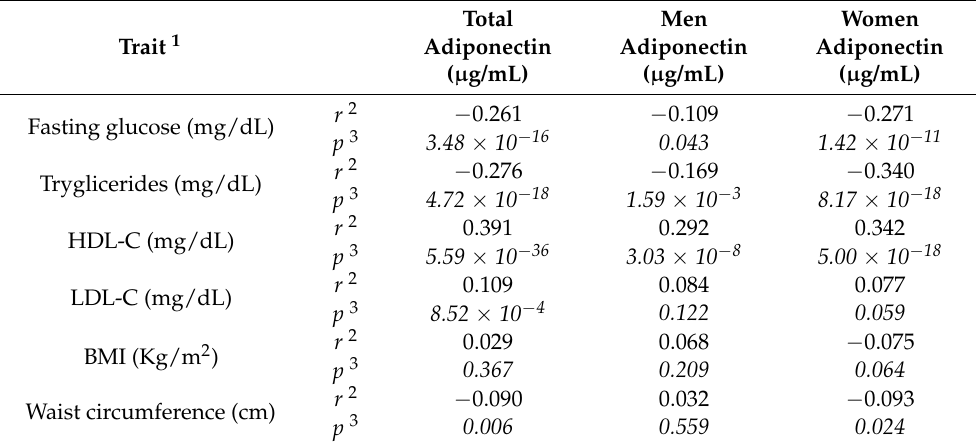
Table 2. Association between plasma adiponectin levels and metabolic traits in the whole population and per sex.